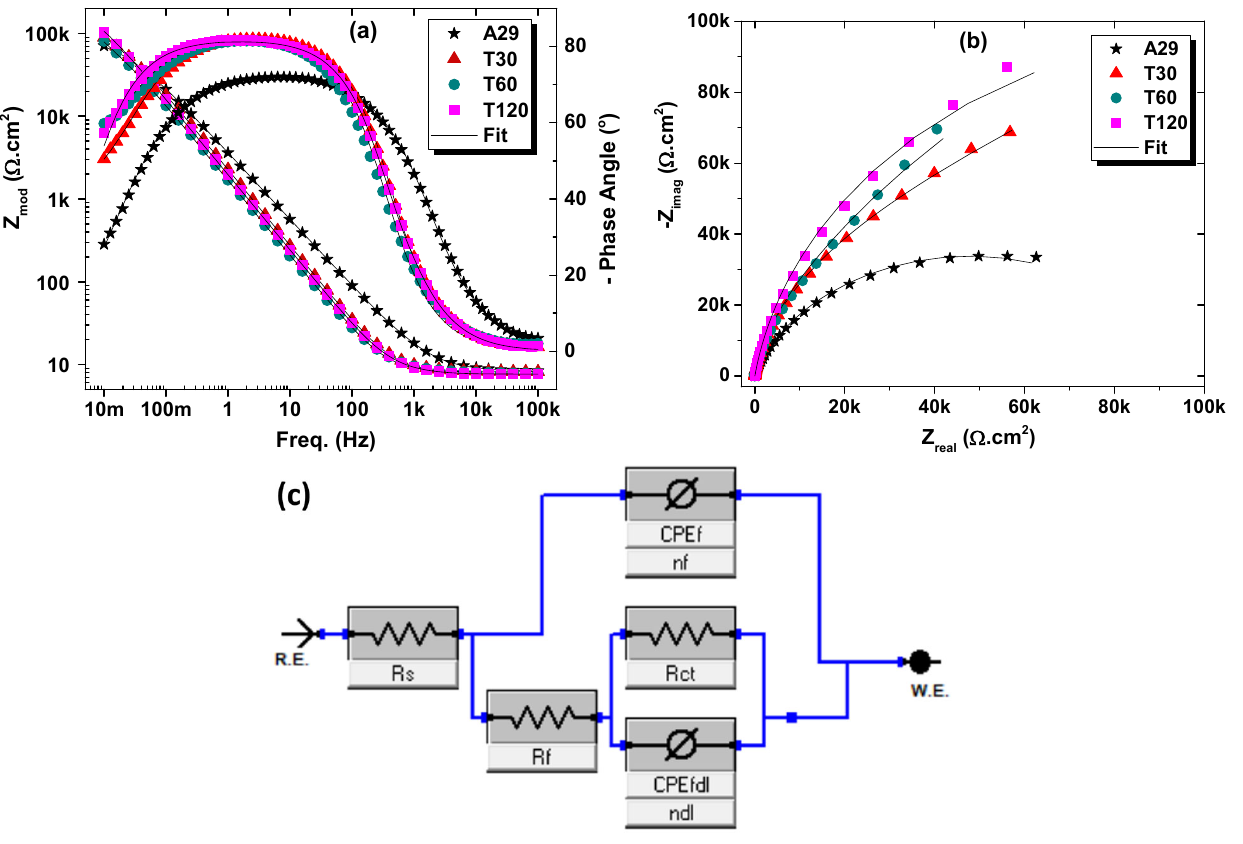
Figure 10. EIS plots, ( a ) Modulus and phase angle, ( b ) Nyquist plots, showing the effect of solutionizing duration on the corrosion behavior of N08029 after 1 hr immersion in 3.5% NaCl aerated solution, and ( c ) Equivalent circuit used in fitting the EIS data.